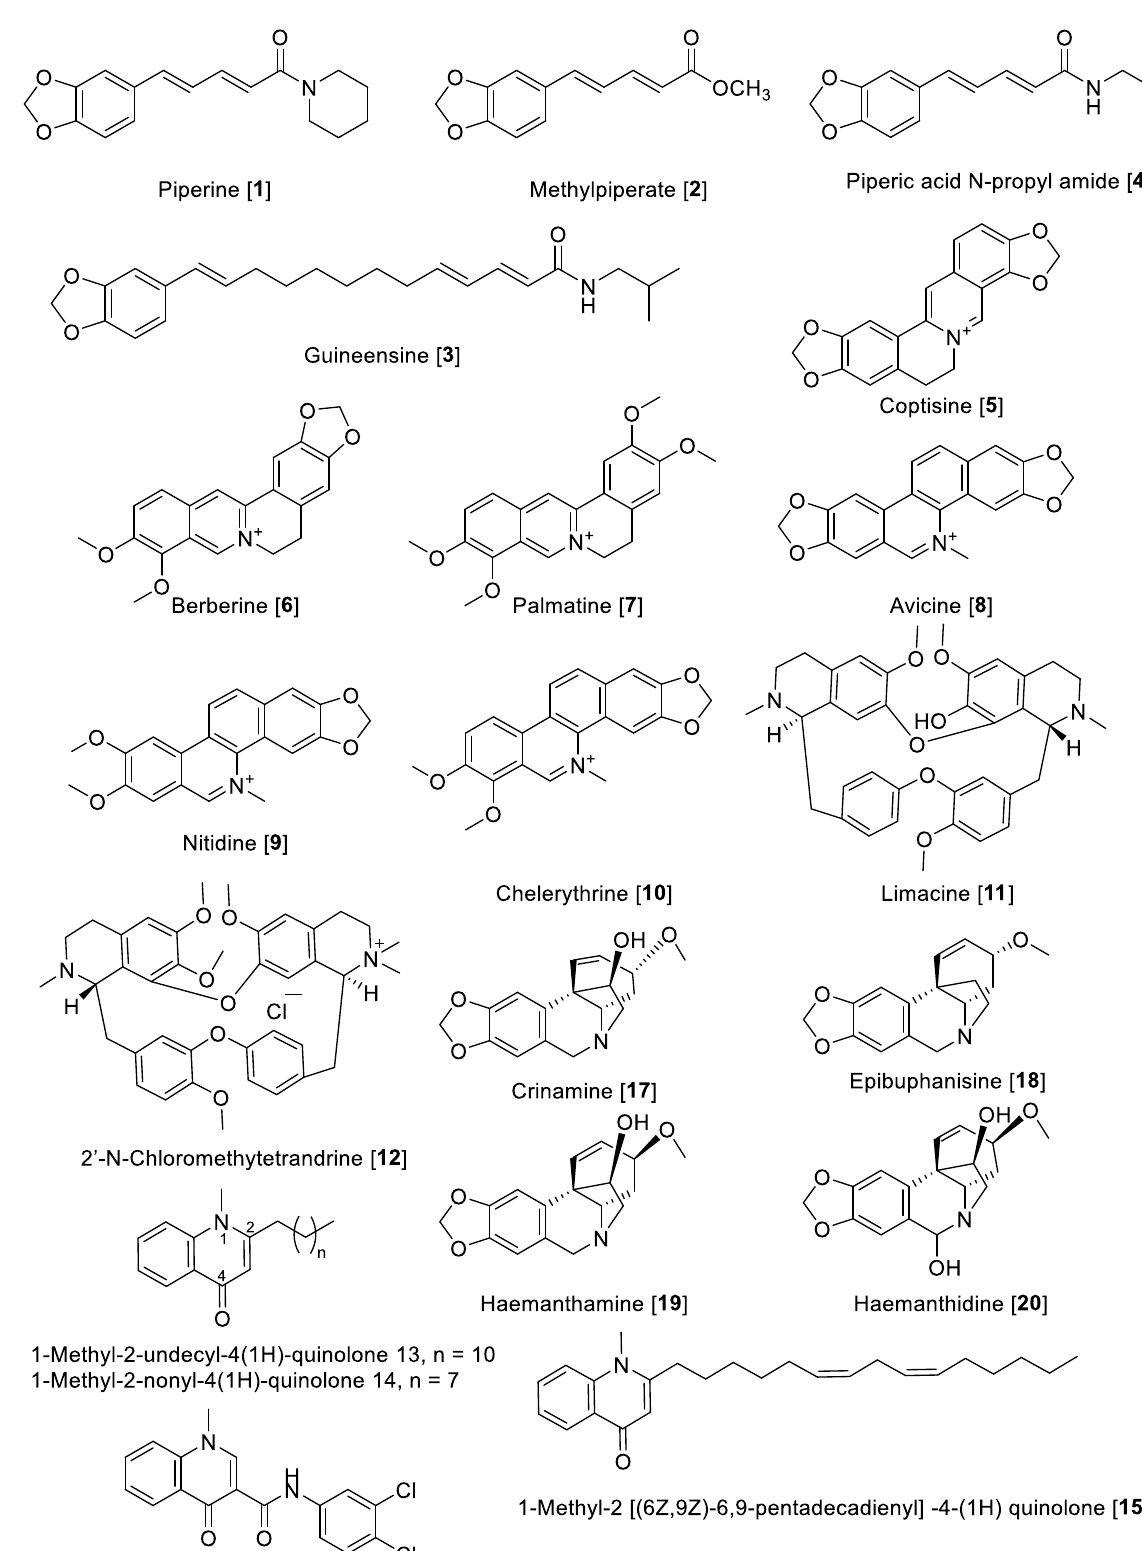
Figure 4. Chemical structure of selected alkaloid MAO inhibitors with piperine, quinolone, and isoquinoline skeletons.